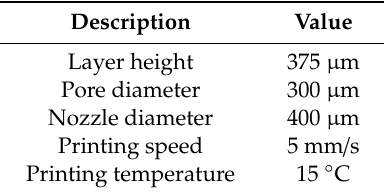
Table 2. The 3DP parameters for